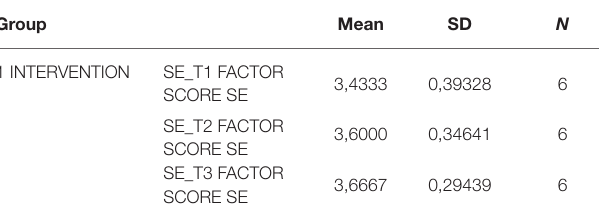
Figure 1 provides a graphical view of the increase in mean values from time 1 to 3 for the Intervention Group. Intervention Group Self-efficacy over Time 1, 2, and 3, displays a graphical view of the immediate change/increase in the intervention groups self-efficacy between time 1 and 2 (time 1 mean = 3,4,333; time 2 mean = 3,6,000). From time 2 to 3, the level of self- efficacy gradually increases/stabilizes (time 2 mean = 3,6000; time 3 mean = 3,6667).